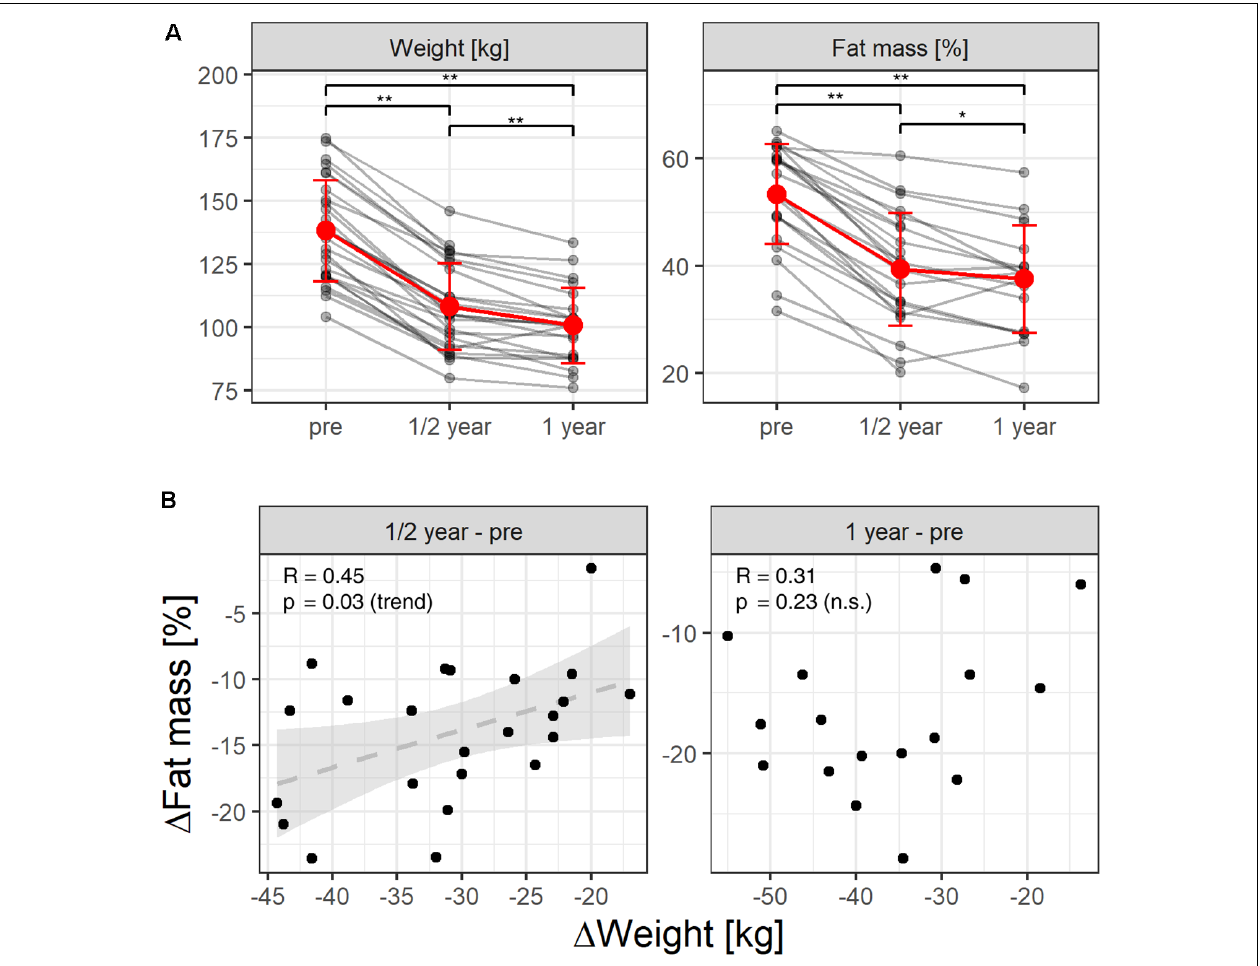
FIGURE 1 | (A) Individual weight and fat loss before and after gastric-bypass surgery (after 6 month and after 1 year). Red color indicates the mean over time. The whiskers the standard deviation. ∗ Indicate a p -value of post hoc t -tests < 0.025, ∗∗ indicate p < 0.001. (B) Pearson-correlation unexpectedly revealed that reductions in fat mass (%) and reductions in body weight (kg) correlated only by trend over the 1st 6 months after surgery, whereas after 12 months we found no correlation between both adiposity measures.